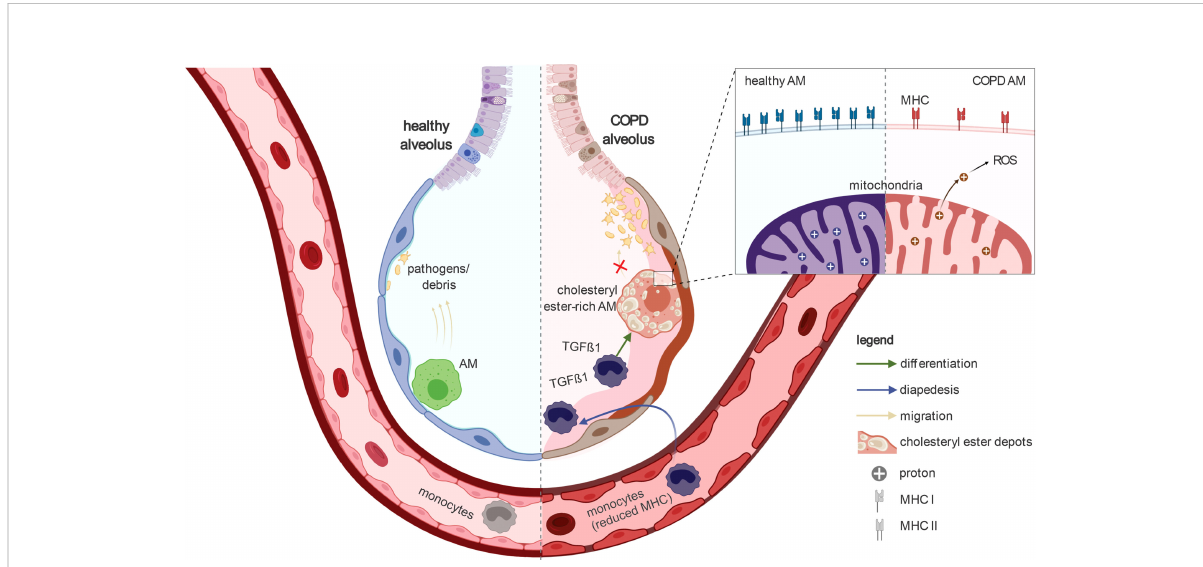
FIGURE 7 Schematic representation of the key fi ndings of the present study In healthy lungs, alveolar macrophages survey the alveoli and remove pathogens and debris to enable proper gas exchange. In the alveoli of COPD patients, the alveolar macrophages accumulate cholesteryl esters. In addition, blood monocytes invade the alveoli and differentiate into alveolar macrophages. The transcriptome of COPD alveolar macrophages indicate TGF- b 1-associated cell signaling especially in the early stages of monocyte-to-macrophage differentiation. The alveolar macrophages in COPD show a reduced ability to migrate towards chemokine. Furthermore, they express fewer MHC molecules; especially MHC class I. Together with the reduced phagocytosis of alveolar macrophages in COPD, the ability of these cells for immune surveillance is severely limited during the disease. In addition, their mitochondria are leaking (e.g. to protons) and therefore produce high amounts of reactive oxygen species. Taken together, the guardians of normal lung function (alveolar macrophages) are severely altered in COPD, preventing them from ful fi lling their important physiological functions properly. Furthermore, the observation of reduced MHC expression in blood monocytes indicates that the manifestation of COPD has a strong systemic